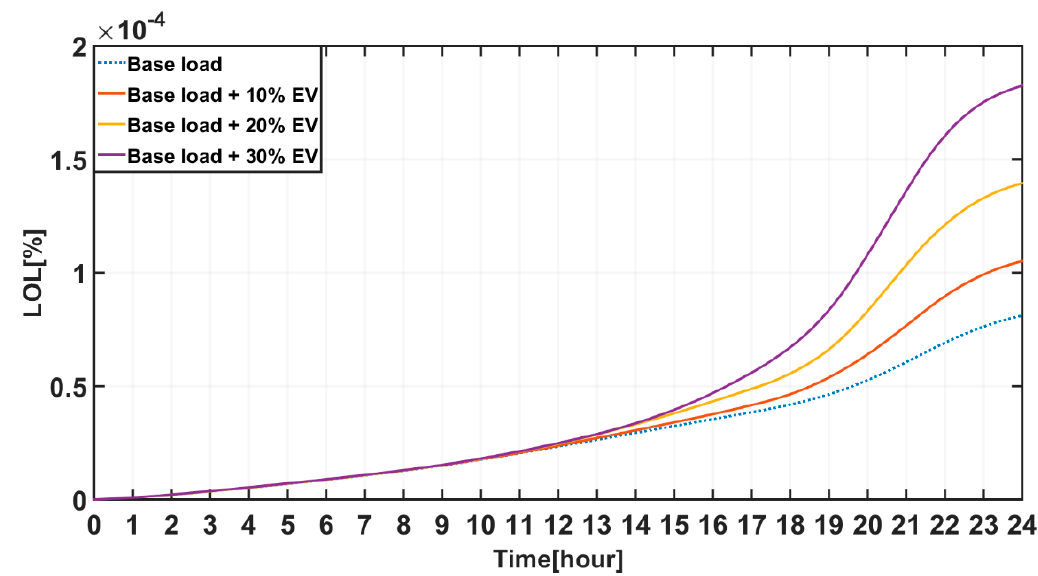
Figure 8. LOL profile with different EV penetration ratio.